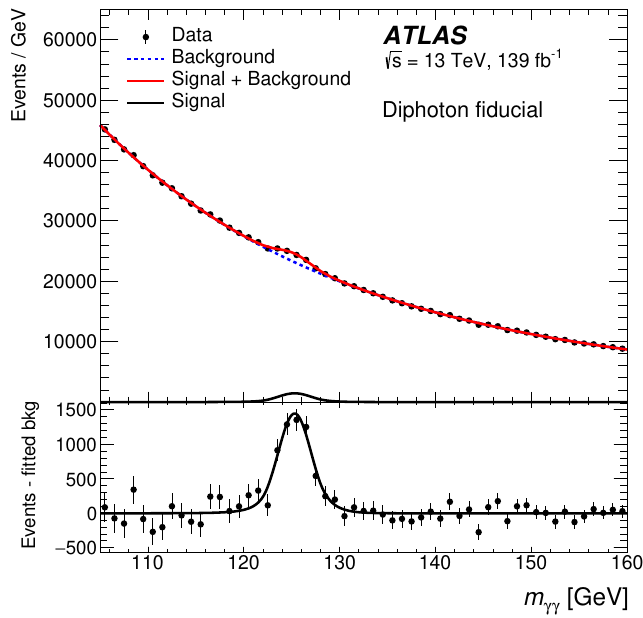
Figure 4. The diphoton invariant mass spectrum of events passing the selection. The solid red curve shows the fitted signal-plus-background model with the Higgs boson mass constrained to 125.09 ± 0.24 GeV. The bottom pad shows the residuals between the data and the background component of the fitted